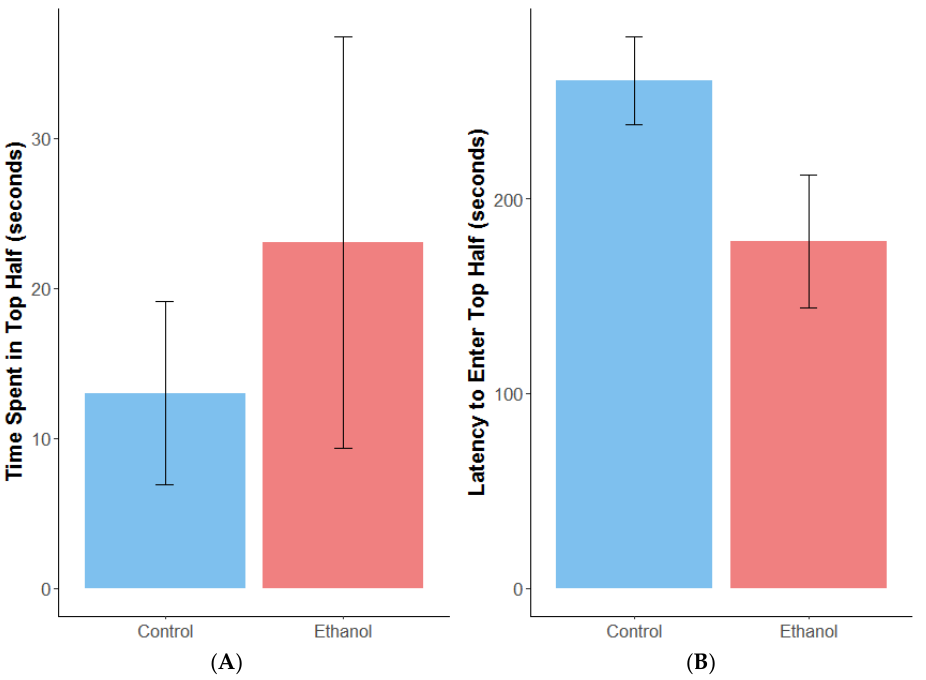
Figure 1. Mean (+/ − SE) allocation of time spent in the top half of the tank ( A ) and latency to enter the top half of the tank ( B ) for adult female zebrafish during the novel tank diving test after exposure to 1% ethanol or water (control). n = 14 for the control and 14 for the ethanol-treated females.